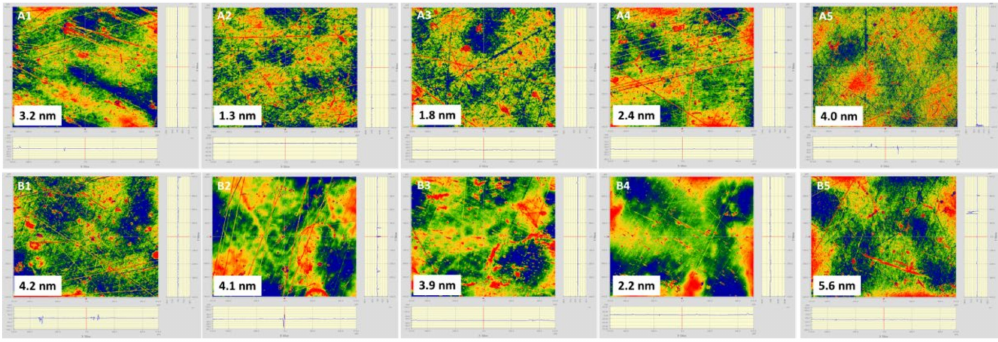
Figure 6. The surface roughness of bare PI membrane on side A and side B.